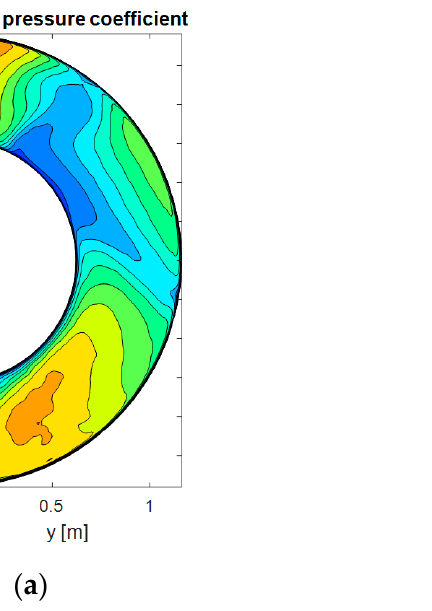
Figure 10. Contours of total pressure coefficient at the AIP. ( a ) PFC with axisymmetric aft fuselage, ( b ) PFC with aft-fuselage upsweep (Source: [58]).